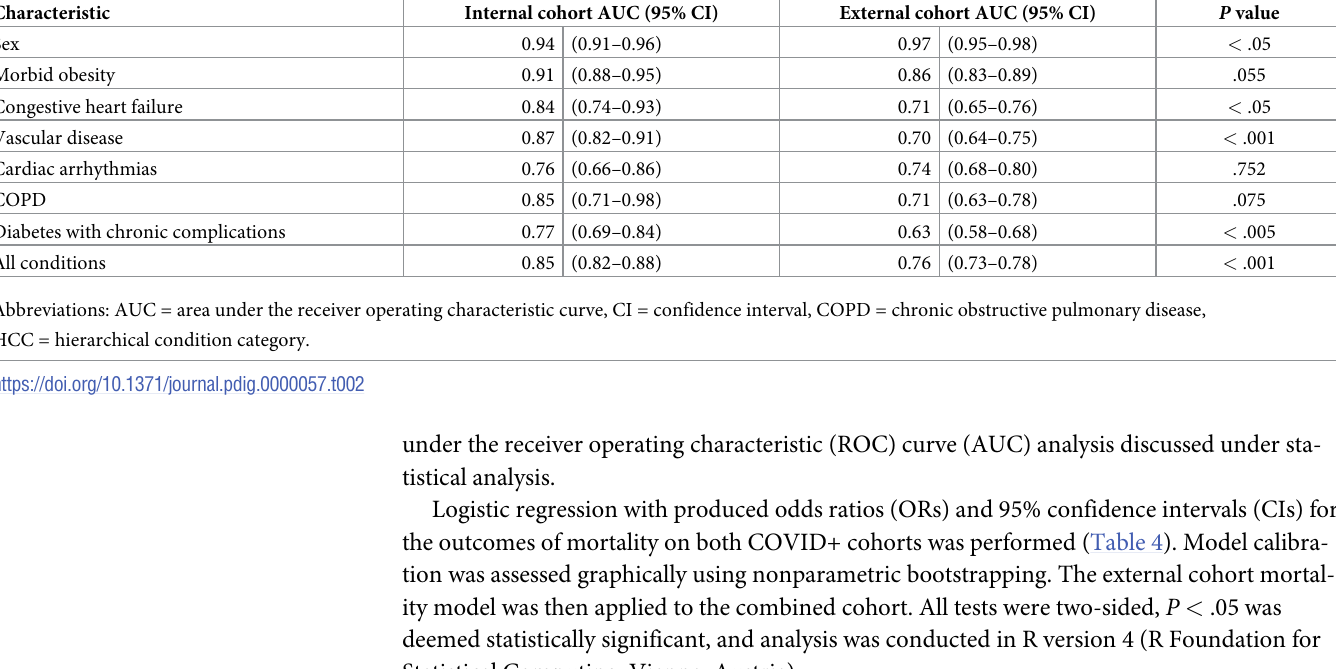
Table 2. Multi-Task Deep Learning HCC-Based Comorbidity and Sex Predictions for Internal and External Cohorts. Characteristic